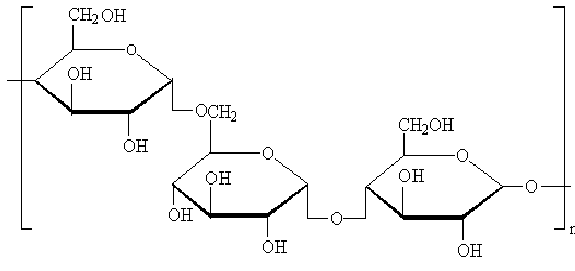
Figure 1. Chemical structure of pullulan.